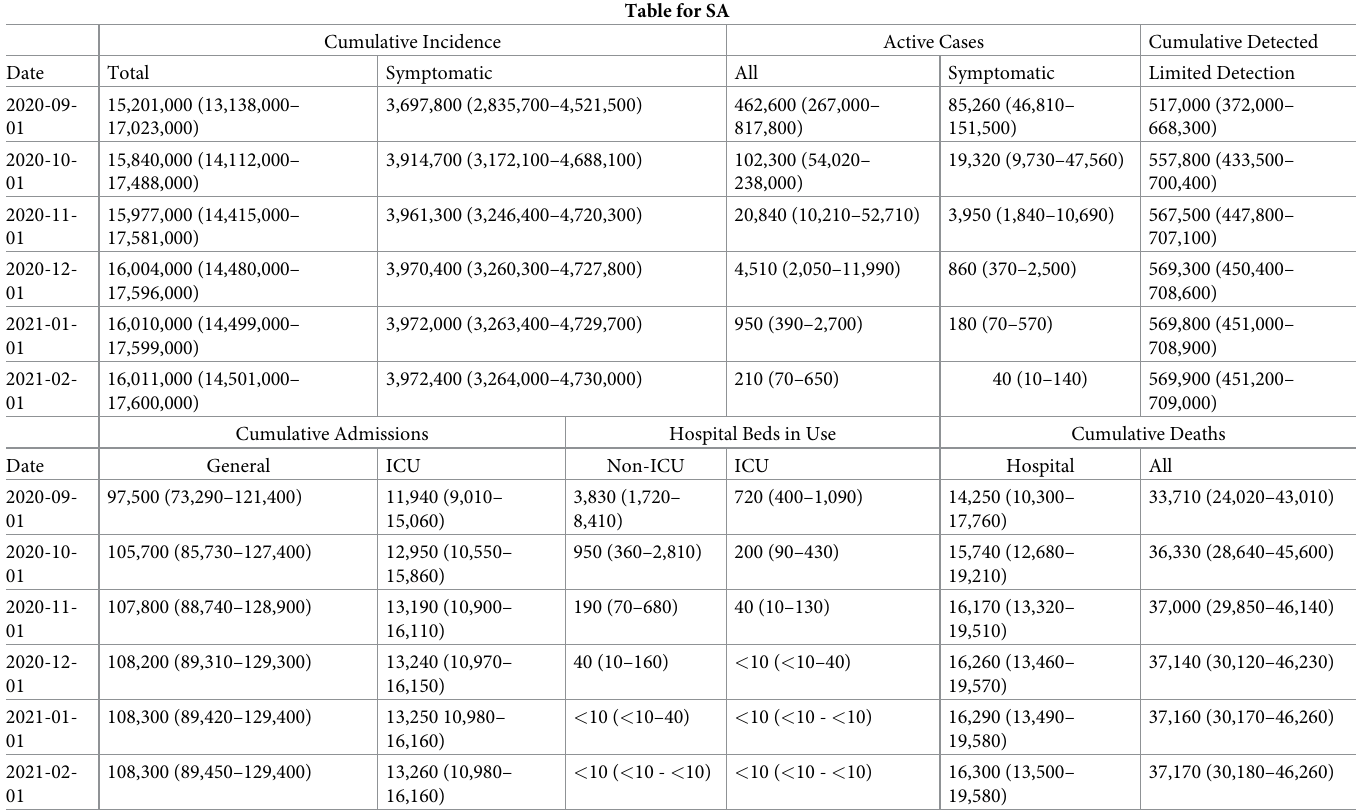
Table 1. Projections of national cases, deaths and admissions needed at select